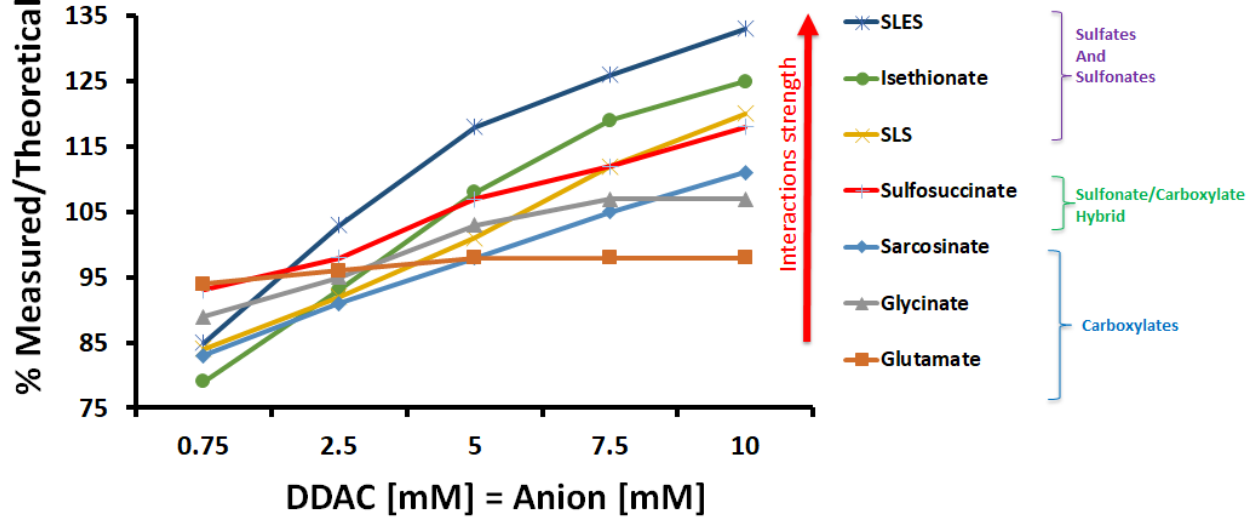
Figure 2. ‘Measured to theoretical conductivity ratio’ for each DDAC:anionic surfactant pair (1:1 molar ratio) at the concentration range of 0.75–10 mM (at 25 °C).